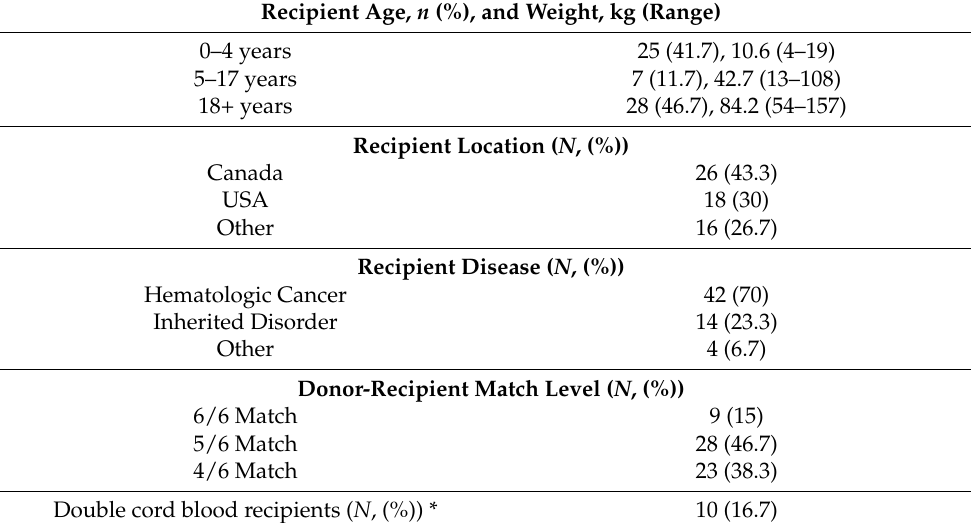
Table 2. Characteristics of cord blood unit